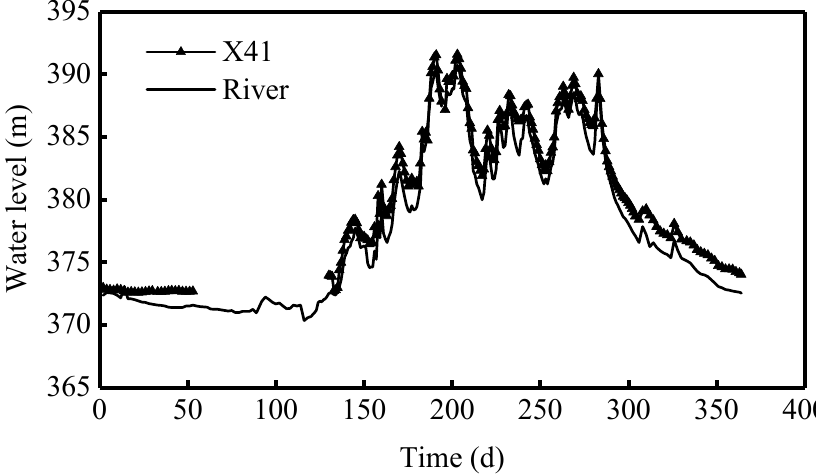
Figure 2. Dynamics of the Jinsha River level and the hydraulic head of the Yangxin limestone confined aquifer.